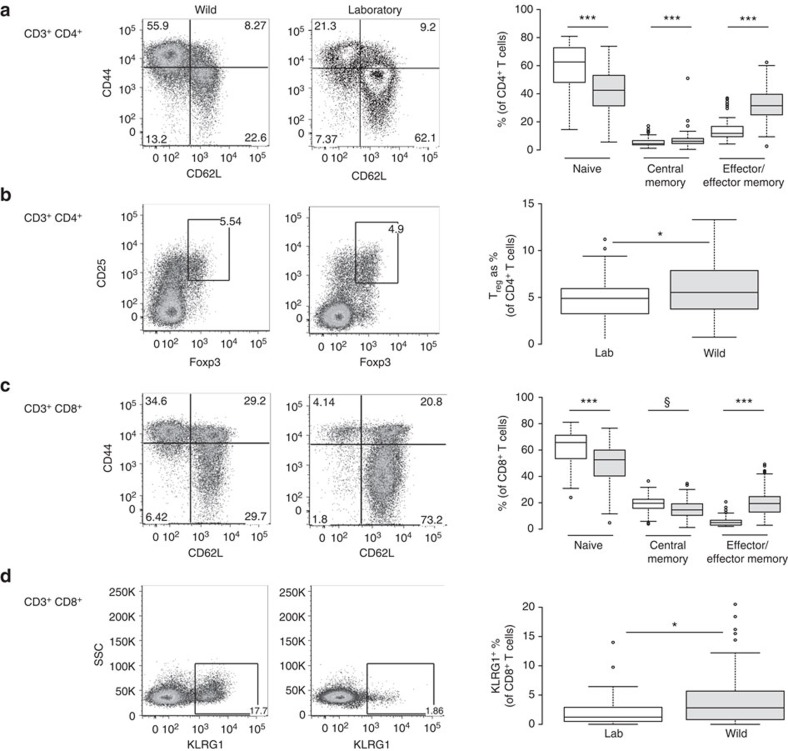
Splenic T-cell populations.The flow cytometry gating strategy and proportions of subsets of CD3+ T cells in wild (shaded) and laboratory (unshaded) mice for (a) CD4+ cells, (b) CD4+ Treg cells, (c) CD8+ cells and their maturation state and (d) terminally differentiated CD8+ cells. CD4+ and CD8+ effector/effector memory cells are defined as CD62L− CD44hi and central memory cells are CD62L+ CD44hi. The box centres are medians, and box limits the 25th and 75th percentiles, the whiskers 1.5 times the interquartile range and outliers are represented by dots. Asterisks denote significant differences as *P<0.05, **P<0.01, ***P<0.001 (Mann–Whitney U test; Supplementary Table 2), and § denotes that there are additional sex effects detailed in Supplementary Table 2. The gating strategy for CD3+ lymphocytes is shown in Supplementary Fig. 1. Sample sizes are shown in Supplementary Table 2 and Supplementary Data 1.